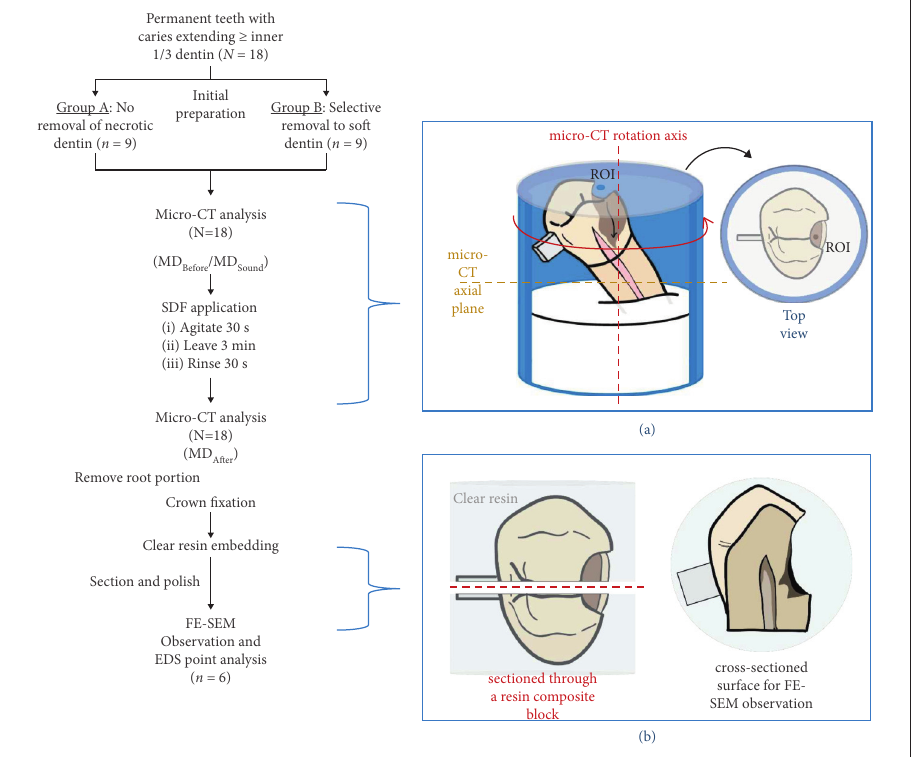
Figure 1: Illustration of the experimental design. (a) The position of the sample for micro-CT scanning; ROI (region of interest). (b) The direction of the sample cross